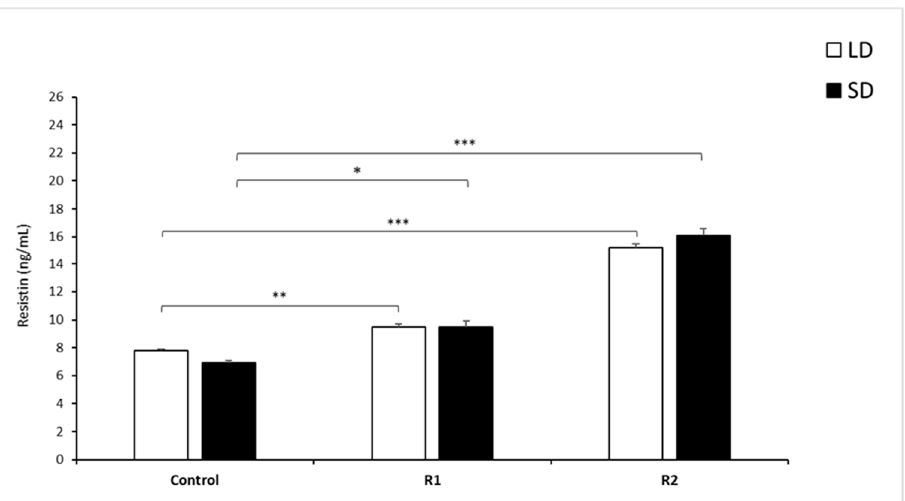
Figure 2. Plasma resistin concentrations. Mean concentrations of circulating (±SEM) resistin in saline (Control) and recombinant bovine resistin-treated groups (R1—low dose; R2—high dose of rbresistin). Only the most important significant differences are indicated by asterisks. Means without a common letter differ. * p < 0.05, ** p < 0.01, *** p < 0.001, denote difference between groups.